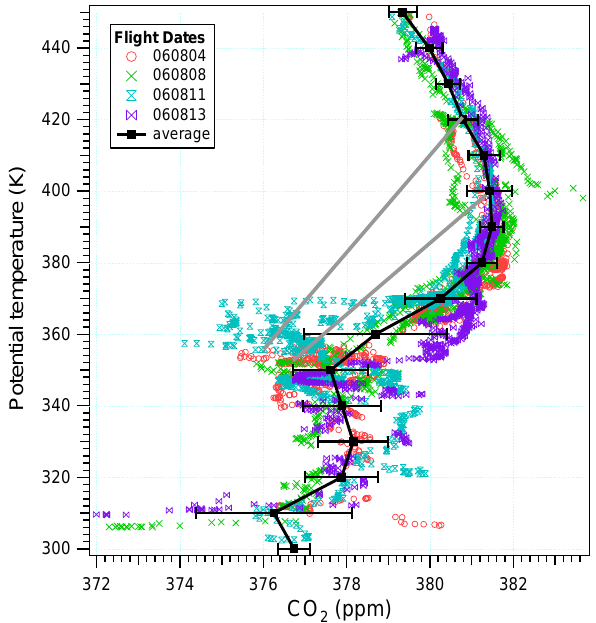
Fig. 4. CO 2 profiles for the local flights during AMMA/SCOUT- O3. Average profile in black. Two examples of possible mixing lines are presented by the grey lines.